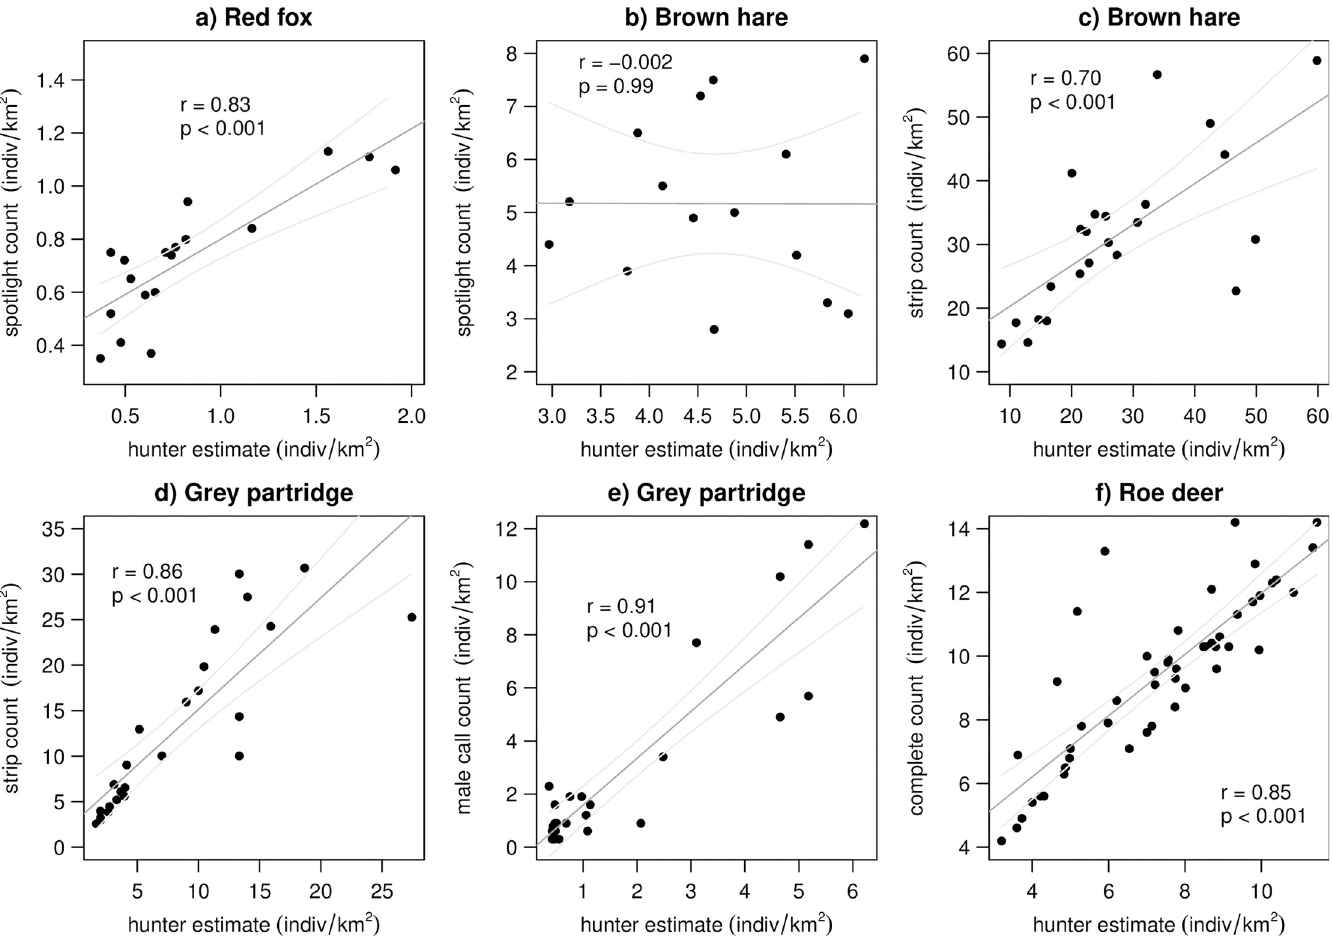
Fig 2. Correlation between hunter estimates of relative population density and estimates of relative density derived by a) spotlight counts from 1997–2014 for red fox, b) spotlight counts from 1997–2002, 2006–2014 for brown hare, c) strip counts from 1960–1980, 1984 and 1988 for brown hare, d) strip or plot counts from 1966–1990 for grey partridge, e) male call counts from 1991–2014 for grey partridge and f) complete counts from 1966–2014 for roe deer. Data from Czempi ń , Poland. Line shown is the fit of a linear regression with 95% confidence intervals for illustration purposes